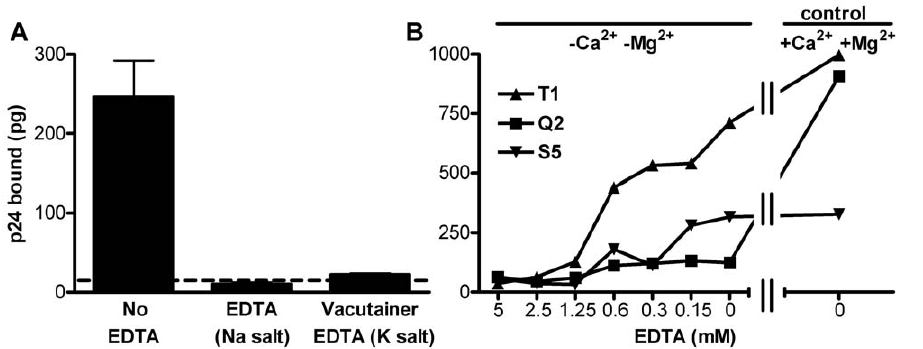
Figure 2. Release of erythrocyte-bound HIV-1 by treatment with EDTA. (A) HIV-1 isolate 89BZ_167 (75,643 pg) was incubated with 5 6 10 8 erythrocytes (donor S4) in RPMI, washed three times, and then treated with either EDTA or RPMI (no EDTA). The bound HIV-1 was completely removed by treatment with EDTA. The dashed line shows the limit of detection of the p24 assay. (B) After incubation of HIV-1 with erythrocytes from 3 different donors, following washing, the cells were incubated with different amounts of EDTA (or no EDTA), and washed either in the absence or presence (control) of Ca 2 + and Mg 2 + .